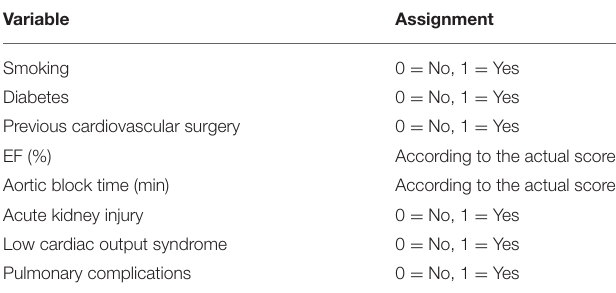
TABLE 4 | Assignment of factors influencing